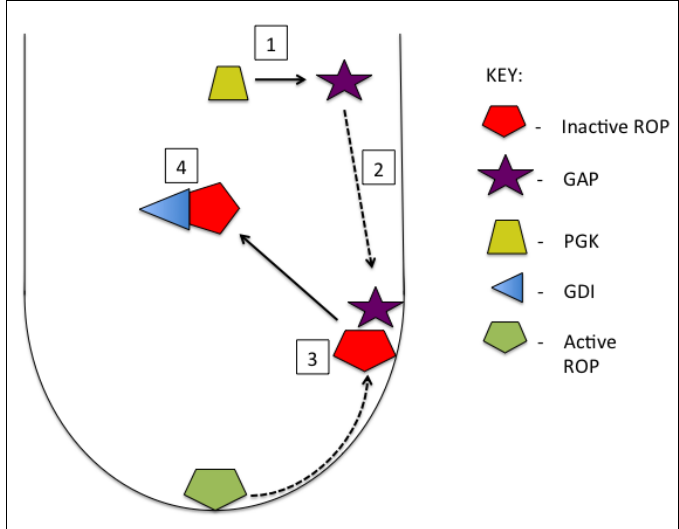
Figure 3. Overview of negative regulation of ROP GTPase. Phosphoglycerate kinase (PGK) acts on Rho GTPase activating proteins (GAPs) (1) to coordinate localization to the membranes flanking the tube apex (2). GAP stimulates the intrinsic GTPase activity of ROP, biologically inactivating the protein as it is passed along the growing tube membrane away from the apex (3). The biologically inactive ROP is bound to Rho guanine dissociation inhibitors (GDIs) in a protein complex sequestered in the cytosol (4).